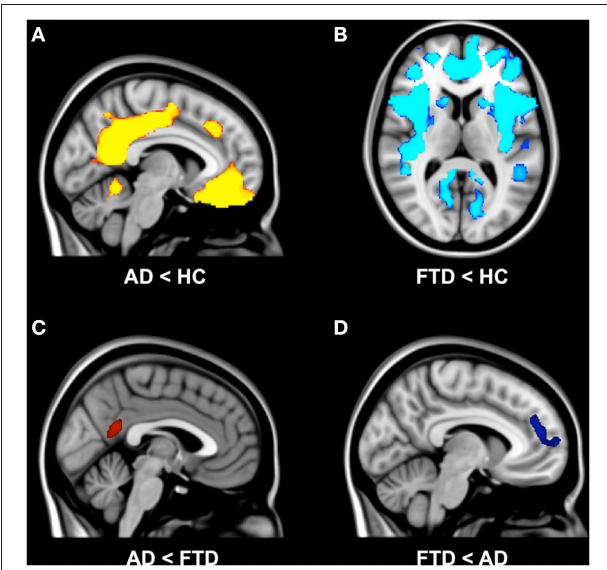
FIGURE 1 | Group differences in gray matter volume. Differences in gray matter volume between behavioral variant frontotemporal dementia (FTD), Alzheimer’s disease (AD), and healthy controls (HC) (TFCE, FWE-corrected). (A) Patients with AD showed less gray matter in precuneal cortex, posterior cingulate cortex, and frontal medial cortex compared with controls. (B) Patients with bvFTD showed less gray matter in anterior cingulate cortex, insular cortex, frontal pole, frontal gyrus, and middle temporal gyrus compared with controls. (C) AD patients had less gray matter compared with bvFTD in precuneal cortex and posterior cingulate cortex. (D) Patients with bvFTD had less gray matter compared with AD in anterior cingulate gyrus and frontal